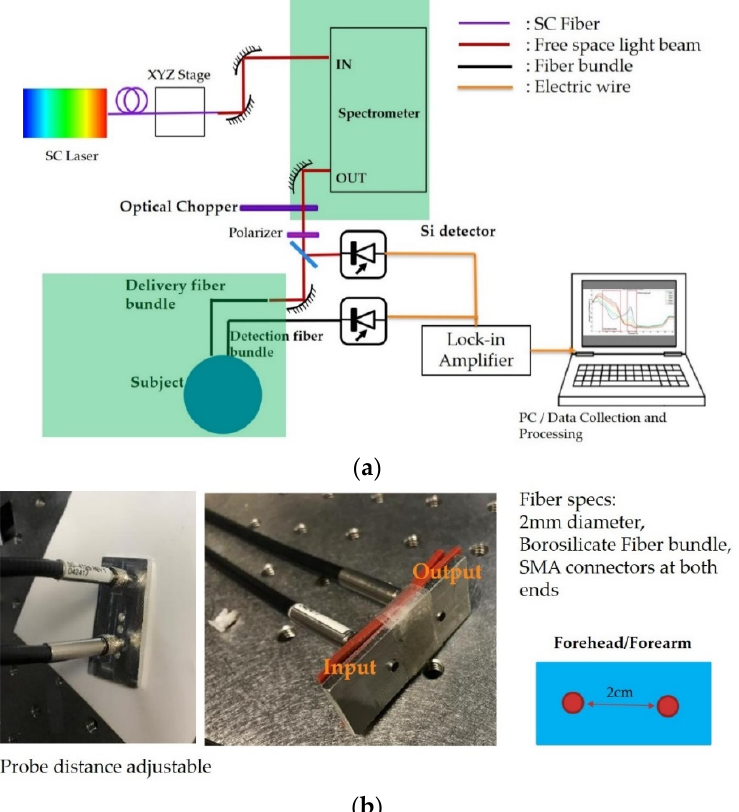
Figure 5. ( a ) Block diagram of optical set-up for SCISCCO system for human testing. (Note that the chopper was moved after the spectrometer due to space constraints, but no change in performance was detected from having the chopper before or after the spectrometer). ( b ) SC probe for placement on human participants for blood pressure and breath-holding tests.